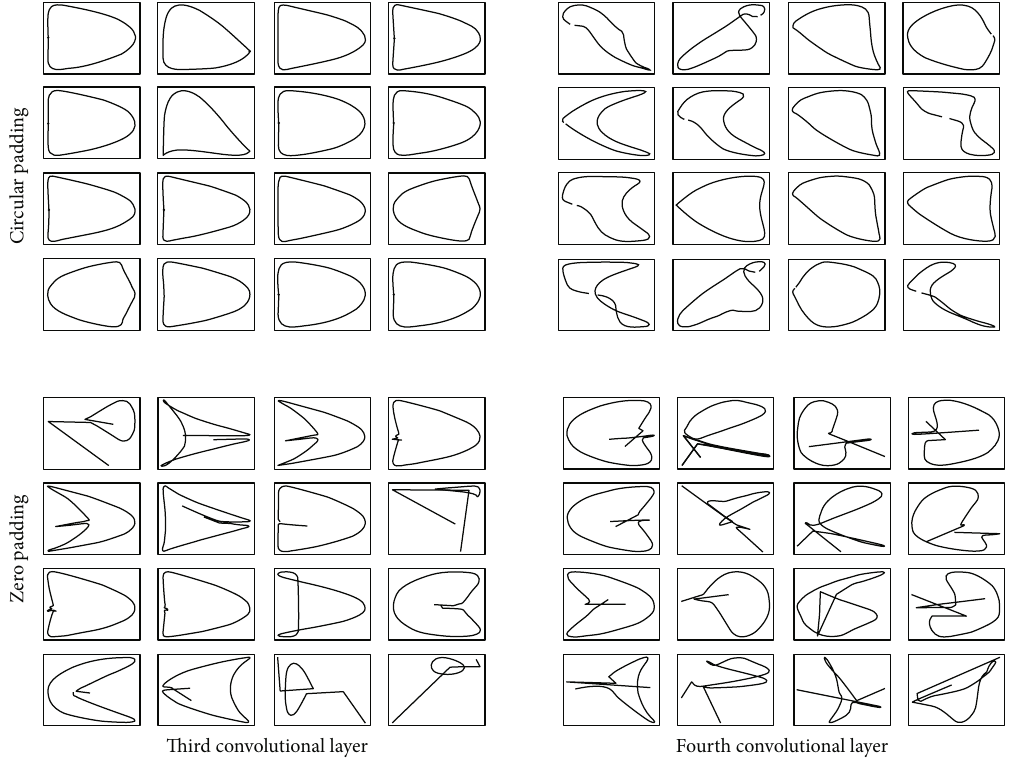
Figure 7: Feature maps of several convolutional layers with di ff erent padding modes.